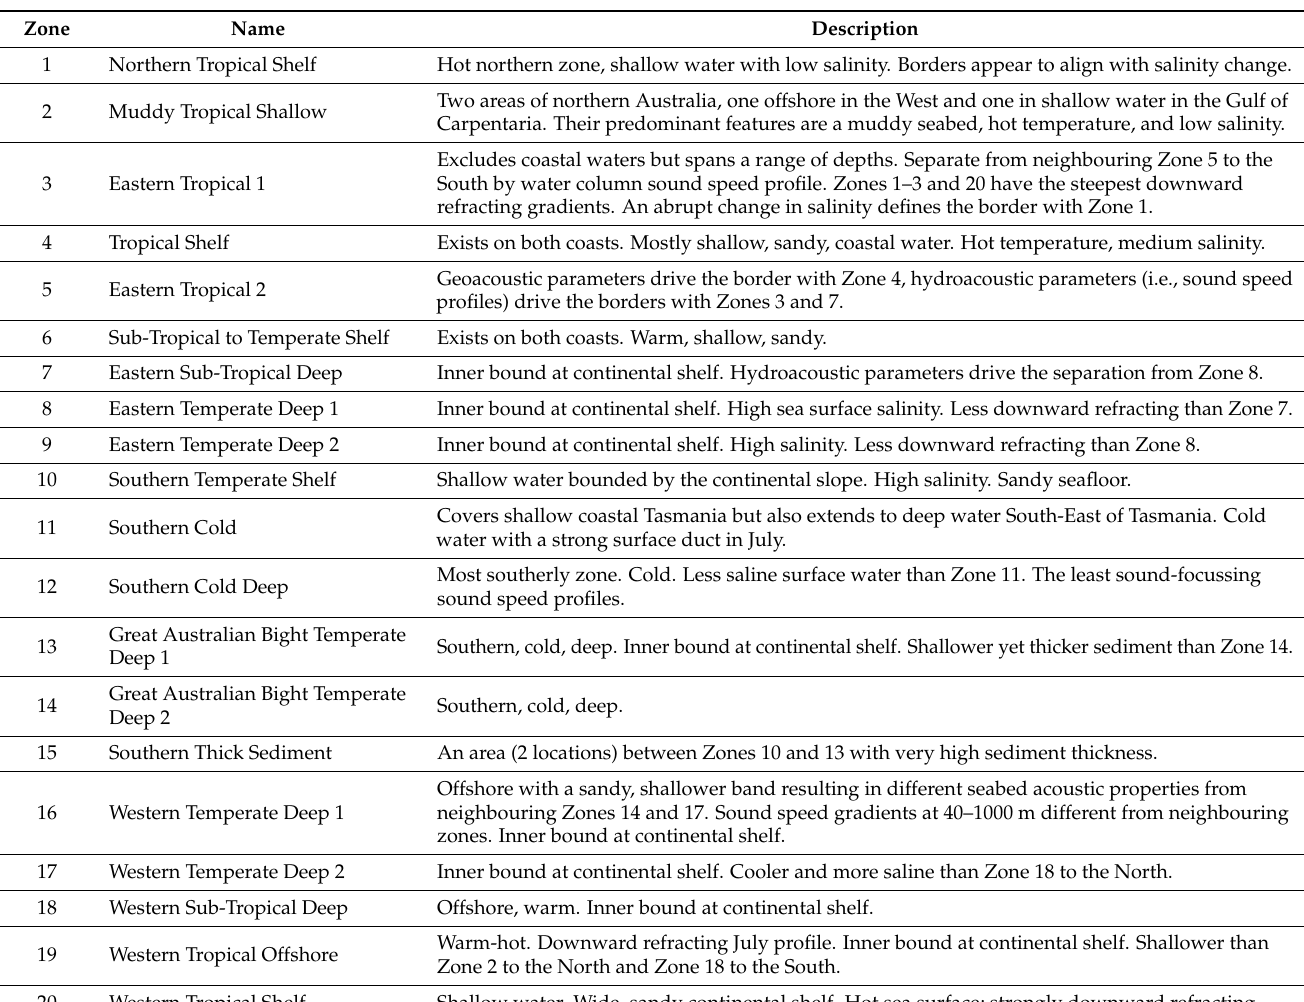
Table 2. Interpretation of zones given by the clustering.